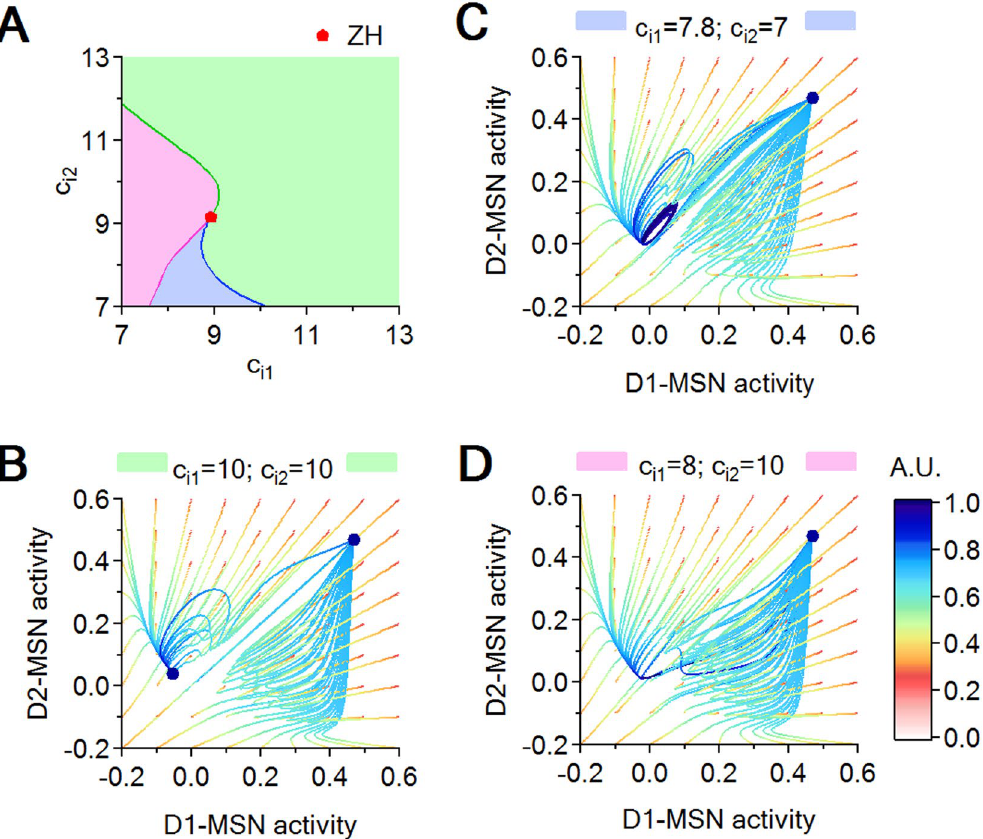
Figure 7. Local bifurcation curves in the c c ( , ) parameter plane and attracting regimes for different c c ( , ) i i 1 2 i i 1 2 pairs. ( A ) Intersection of H (blue), LP (green) and LPC (pink) curves at a Zero Hopf (ZH) point. The three different regimes delimited by these curves are color-coded in pink, green and blue. ( B – D ) Each panel illustrates a generic phase plane slice for one of the three parameter Effect of local and coupled changes in the E/I of D1- and D2 -MSNs.